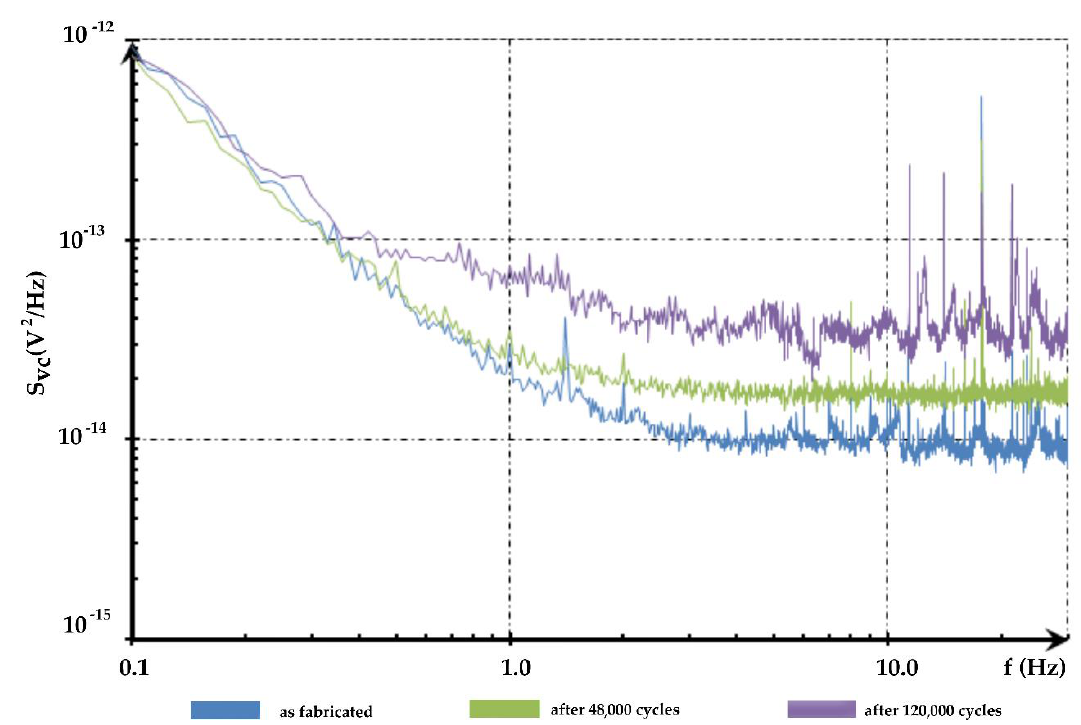
Figure 9. Power spectral densities of the identified voltage fluctuations across the tested prototype sample after selected number of charging/discharging cycles at a current density of 5 A/g and polarizing voltage 1.5 V.